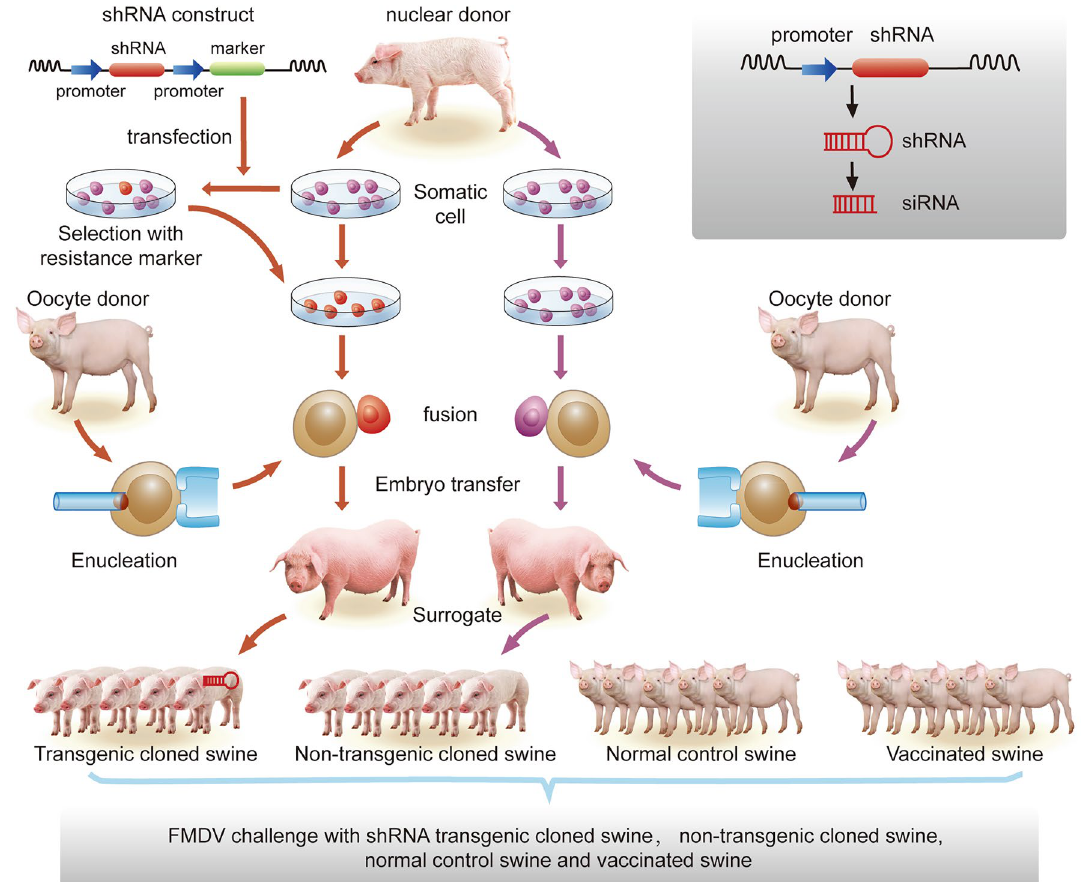
Figure 2. Production of transgenic cloned swine and Non-transgenic cloned swine by SCNT. A male Landrace swine was used as a nuclear donor, and an embryonic fibroblast cell line was established. In the left flow (orange), the shRNA construct was transfected into the embryonic fibroblasts and selected with a resistance marker (the real and clear vector was shown in Supplementary Fig. S1, expressing the 3D-shRNA, EGFP, Neo-R, and 2B-shRNA). The transgene-positive fibroblasts were fused with an enucleated oocyte. The reconstructed embryo was transferred to a surrogate, and the transgenic cloned swine were born. In the right flow (purple), the embryonic fibroblasts were directly used as the nuclear donor cell and fused with an enucleated oocyte. The Non-transgenic cloned swine were born. Then, to determine the anti-FMDV response of the shRNA transgenic cloned swine, we used similar Landrace animals as the Normal control swine and Vaccinated swine to perform the FMDV challenge shRNA-expression vector induced antiviral effects toward FMDV in both the BHK-21 and IBRS-2 transgenic cells. The viral titers in the supernatants of the BHK21-P cells were reduced by 81% at 12 h.p.i. and by ~ 100% at 24, 48, and 72 h.p.i. compared to the BHK21-N cells and showed significant differences at all of the time points ( P < 0.01) (Fig. 1c). Similar results were determined in the IBRS-2 cell lines (Fig. 1c). Generation of transgenic cloned swine and quantification of shRNA expression in swine. The somatic cells were obtained from the nuclear donor. Some of the somatic cells were transfected with the line- arized shRNA expression vector p3DEN2B. The positive transgenic cells were selected with EGFP and the resist- ance marker Neo-R and were used to produce transgenic cloned swine by somatic cell nuclear transfer (SCNT). The other portion of the somatic cells from the same nuclear donor was used to produce Non-transgenic cloned swine by SCNT (Fig. 2). Thirty-two cloned swine were born, of which 23 positive transgenic cloned swine (19 were alive) and 9 non-transgenic cloned swine (five were alive) were confirmed. The transgenic cloned swine and Non-transgenic cloned swine were cloned from the same somatic cell line and shared the same genome, except for the transgene. The siRNA expression in the transgenic cloned swine was detected by one step qRT-PCR. In the five tested tissues, including the heart, skin, lung, submaxillary lymph node, and kidney, all of the TGCS had a detectable siRNAs expression. The siRNA expression level was approximately 1.1 in the kidney and approxi- mately 0.02–0.08 in the other 4 tissues, with the U6 RNA used as an internal control (Supplementary Fig. S4).